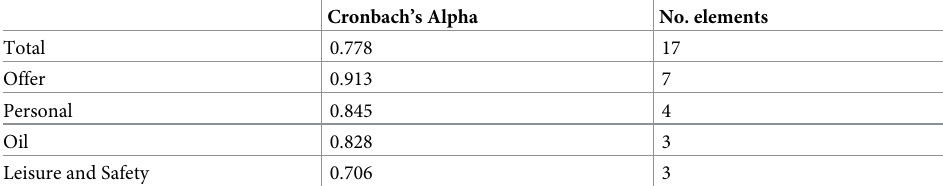
Table 6. Reliability statistics.